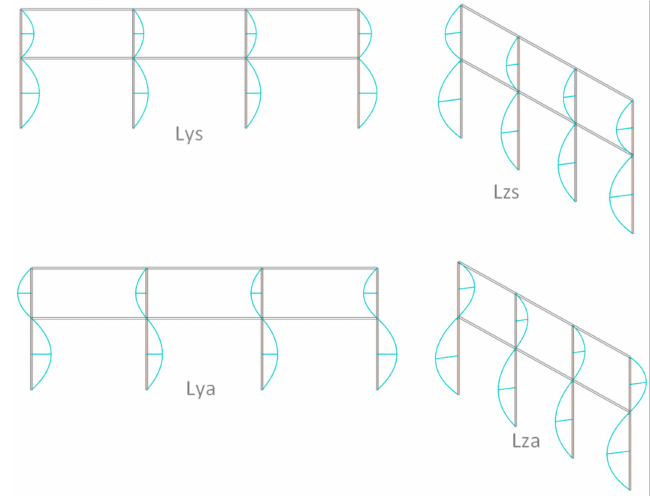
Figure 5. Examined shapes of local bow imperfections.